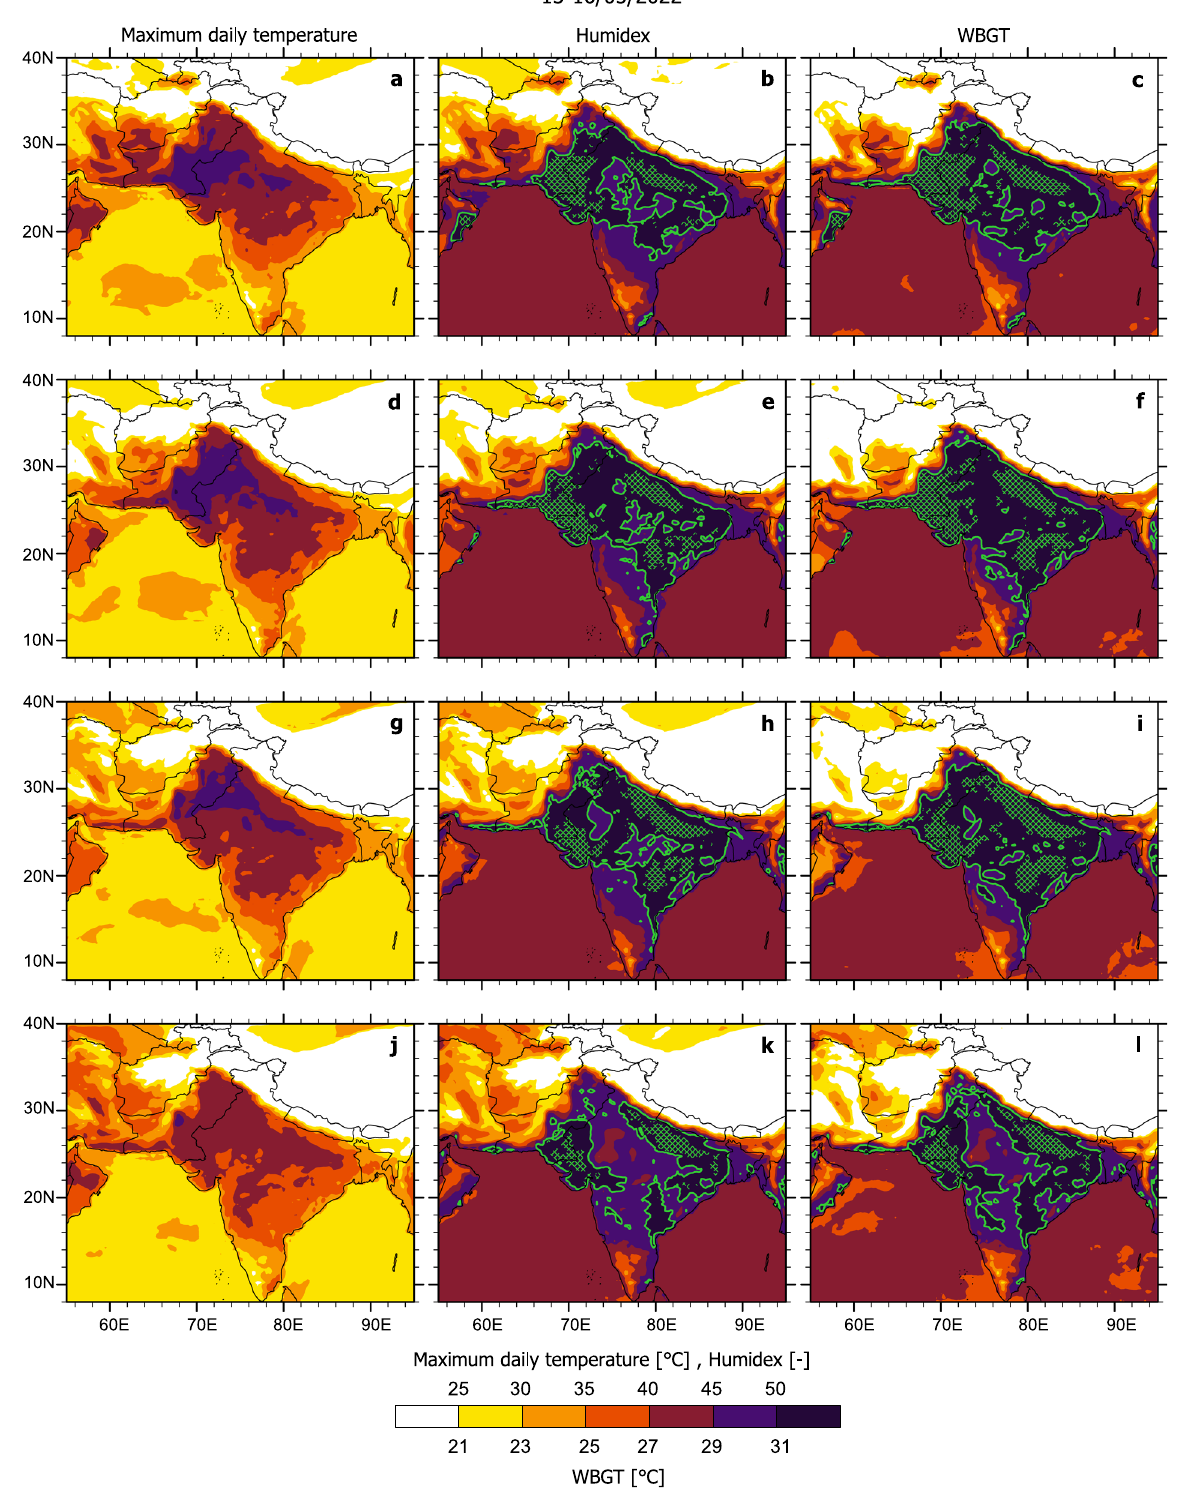
Fig. 2 Maximum daily temperature [°C], humidex [unitless] and indoor Wet Bulb Globe Temperature (WBGT) [°C] during four selected days of the May 2022 Pakistan-India heatwave. Conditions shown are for the 13 th ( a – c ), 14 th ( d – f ), 15 th ( g – i ) and 16 th ( j – l ) of May 2022. Green contours indicate regions with humidex above 50 and indoor WBGT above 31 °C, where the critical threshold values de fi ning dangerous heat stress conditions were exceeded; green stippled regions indicate humidex values above 54 and WBGT above 33 °C (these values have not been reached in the three heatwaves considered in Fig.